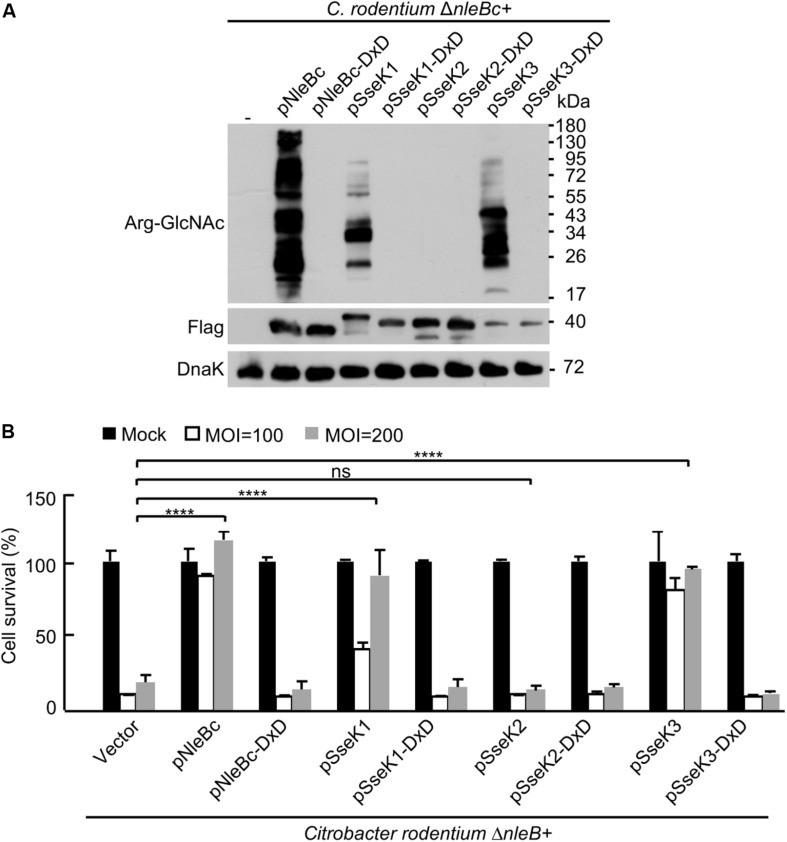
Chimera SseK1 and chimera SseK3 inhibits TNF-induced cell death during C. rodentium infection on MEF cells. (A) Complementation strains of ΔnleB with Citrobacter NleBc or chimera SseK1/2/3 and their enzyme inactivated mutants were generated. Single colony of each strain was inoculated and incubated overnight with the corresponding antibiotics. Bacterial lysates were collected and samples were loaded onto SDS-PAGE gels, followed by standard immunoblotting analysis. (B) NleB and SseK1/3 mediate inhibition of TNF-induced cell death in MEF cells during C. rodentium infection. MEF cells infected with derivatives of C. rodentium strains were stimulated with TNF. Cell viability was determined by measuring ATP levels. ****P < 0.0001 (one-way ANOVA), ns, not statistically significant. Data are representative from at least three repetitions.